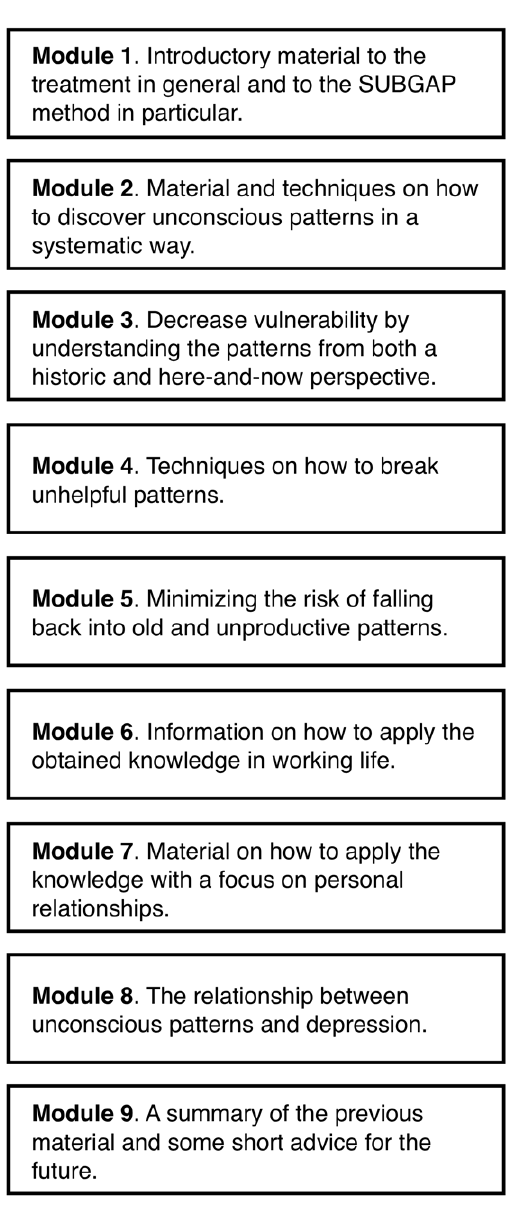
Figure 2. Description of the self-help modules in the psycho- dynamic